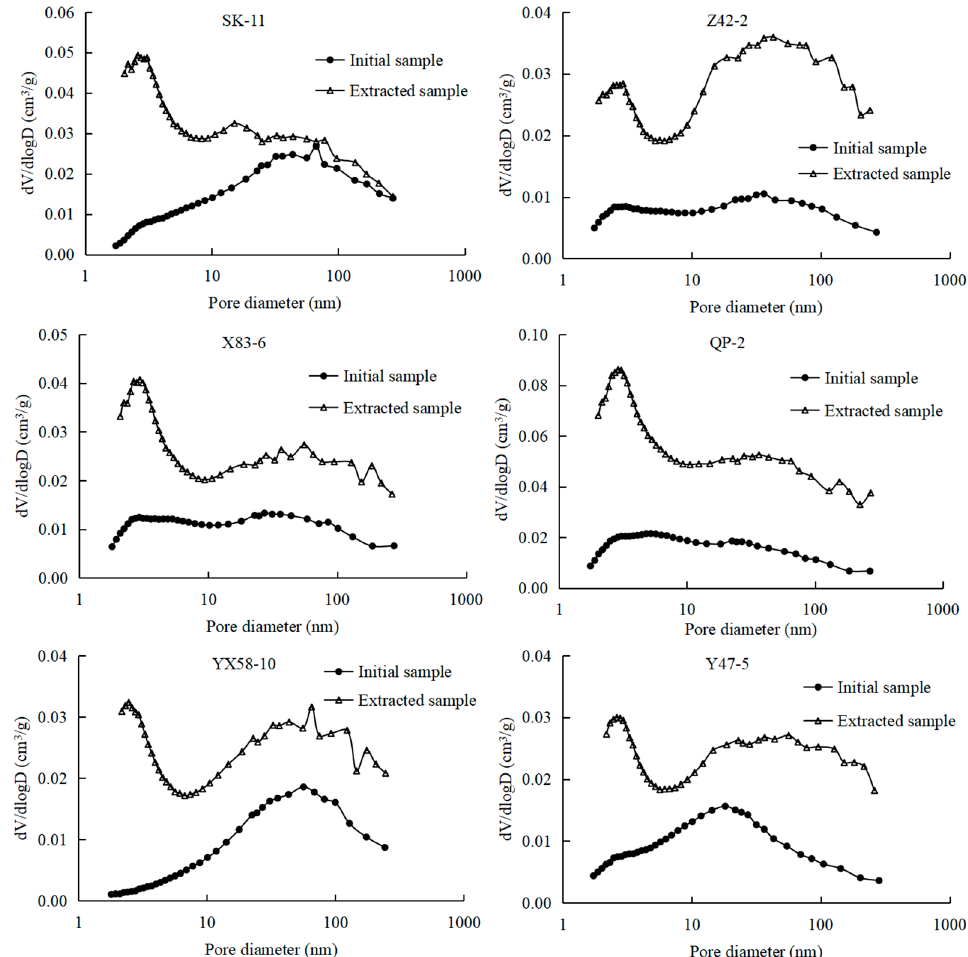
Figure 5. Plots of dV/dlog (D) versus pore diameter for the PSD of the initial and extracted samples for the typical K 2 qn shales.